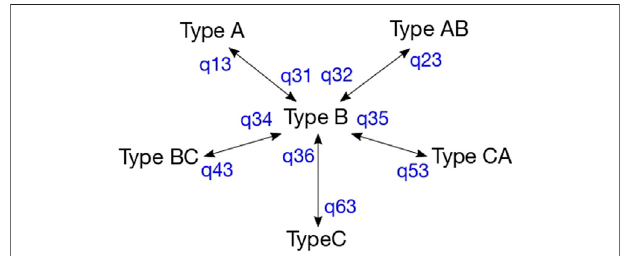
FIGURE 12 | Star-like model ALL_THROUGH_B where all diachronic change is led through a single “ hub, ” type B.